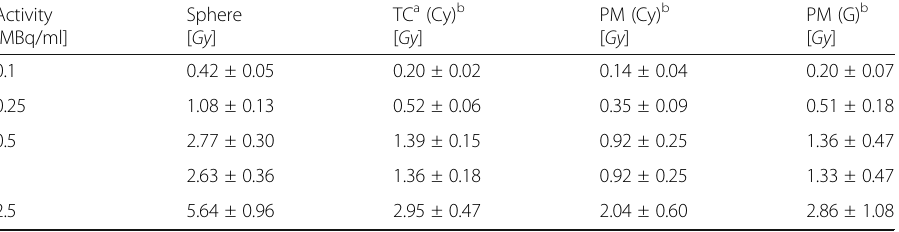
Table 5 Absorbed dose to the nucleus corresponding to each added activity for the 4 geometrical modeling assumptions